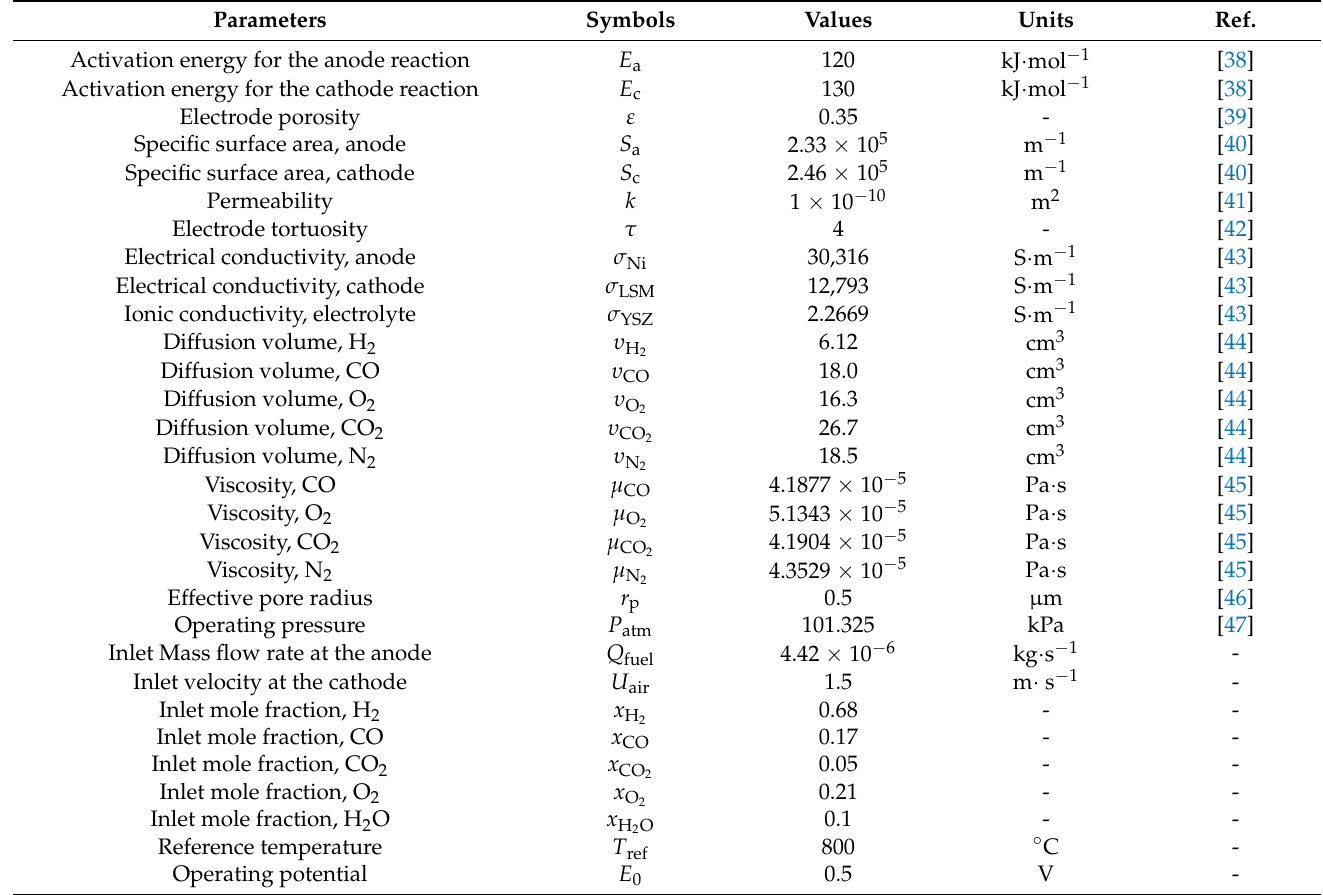
Table 3. A summary of the parameters used in this study. Parameters Symbols Values Units